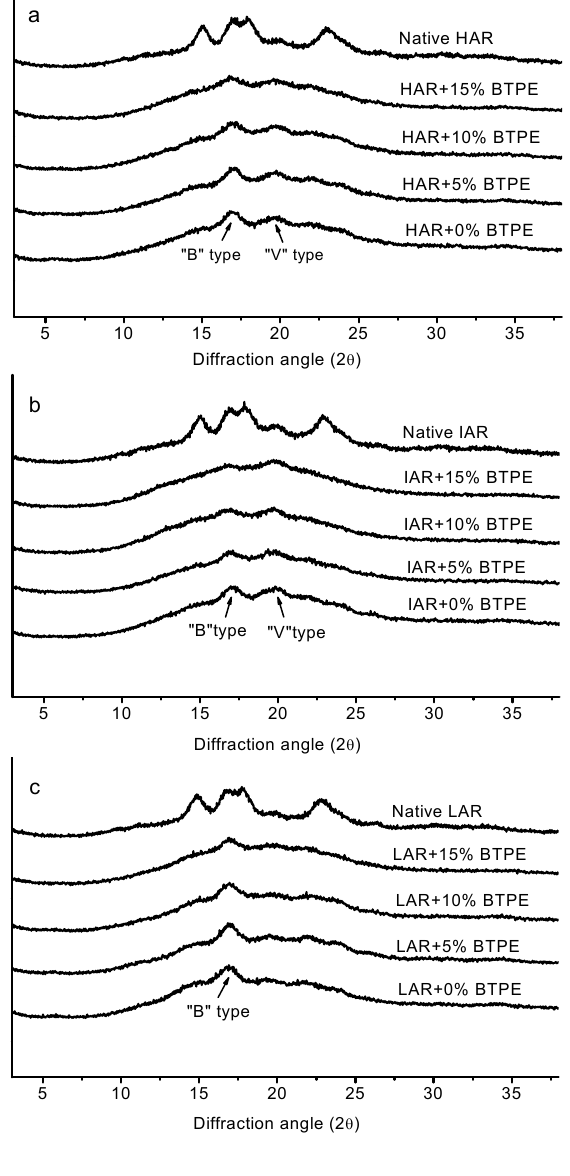
Figure 2. X-ray diffraction of native starch and gelatinized starch gels from different rice varieties containing different levels of black tea polyphenol extract (BTPE) after 10 days storage at 4 °C. ( a ) HAR, rice starch with high amylose content, the same as RS; ( b ) IAR, rice starch with intermediate amylose content; ( c ) LAR, rice starch with low amylose